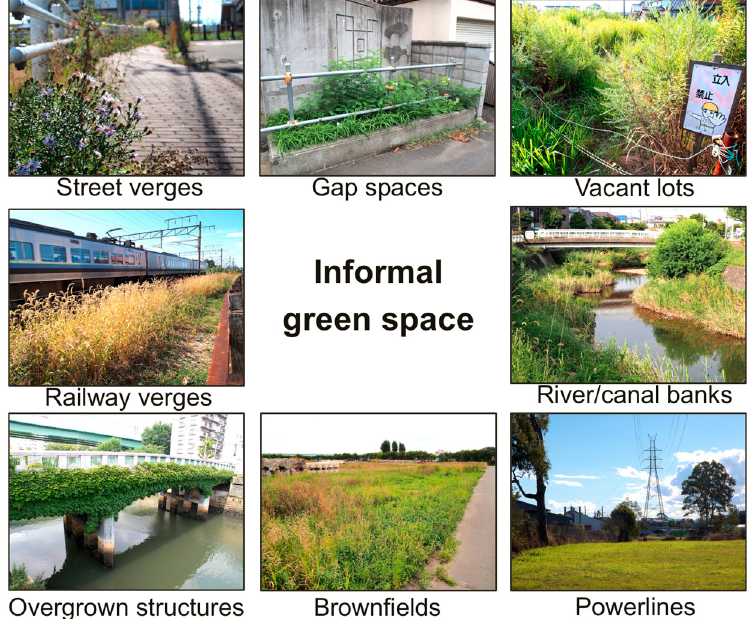
Figure 2. Typology of IGS (translated to English) with example photographs of different IGS types, as shown to respondents in the online survey. From top left, clockwise: street verge, gap, vacant lot, waterside, power-line corridor, brownfield, structural IGS, railway verge.